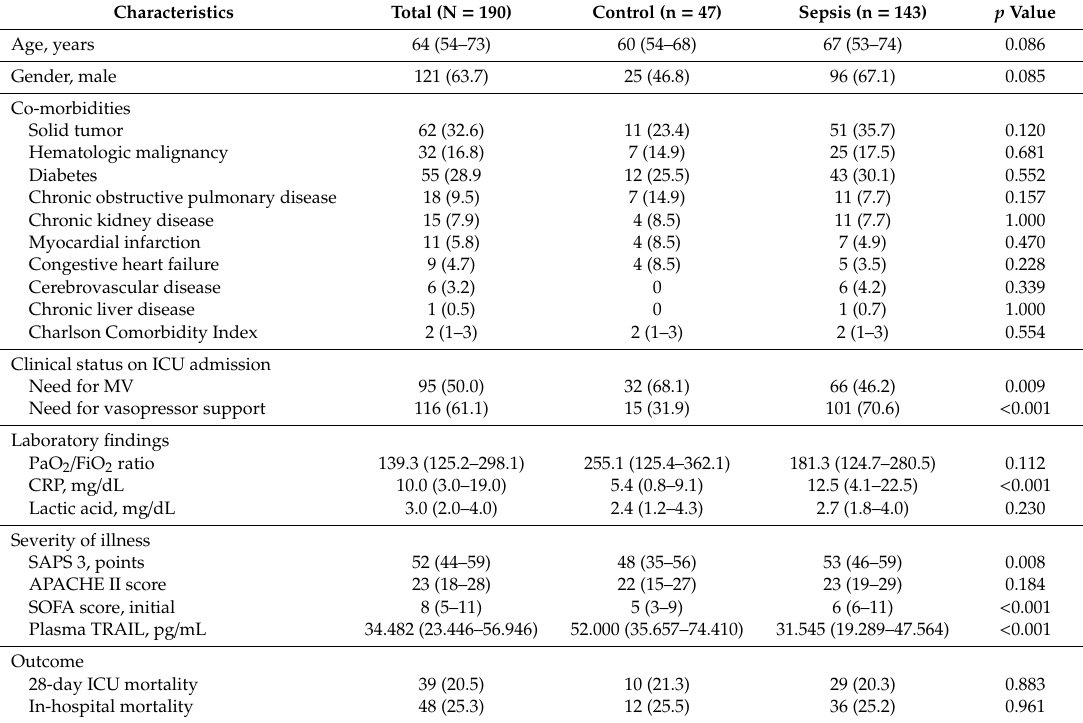
Table 1. Baseline characteristics of study patients (n =